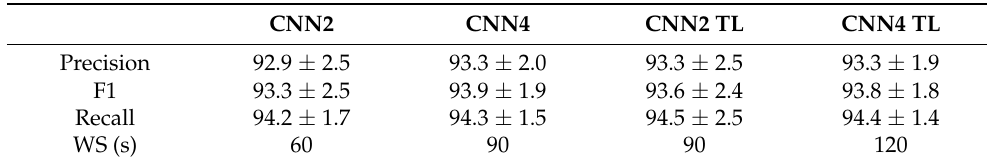
Table 2. Comparison of model performance trained by simple training and transfer learning. Pre- cision, F1 and recall values are given averaged (mean ± STD) for a 10-fold validation for optimal window sizes (WS), presented in Figure